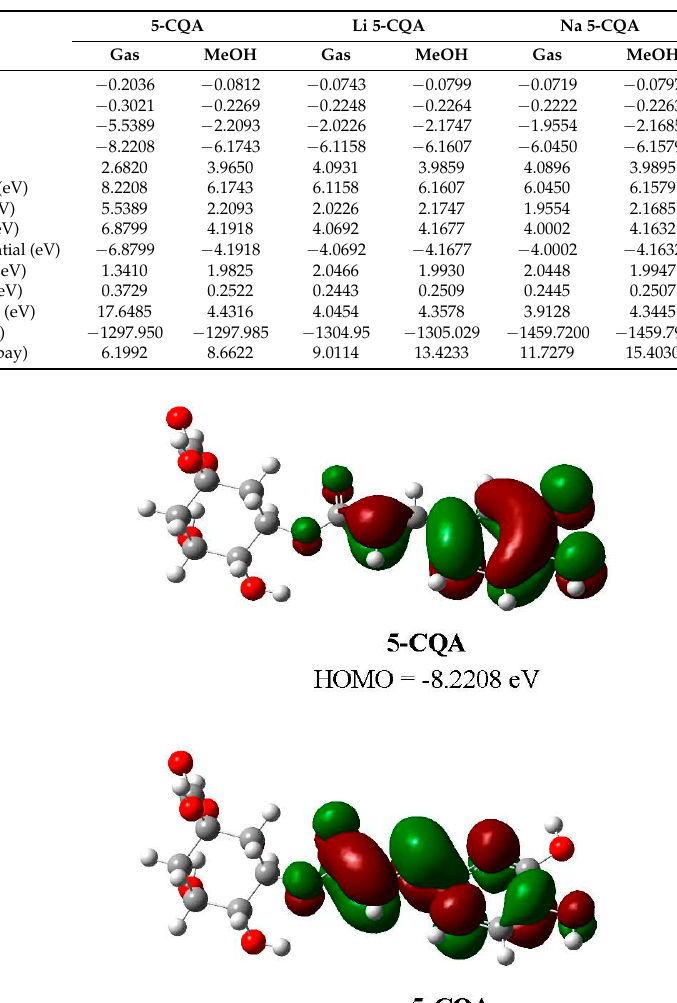
Table 6. Calculated (in B3LYP/6-311++G** level) electronic parameters for 5-CQA and Li, Na and K 5-CQA.